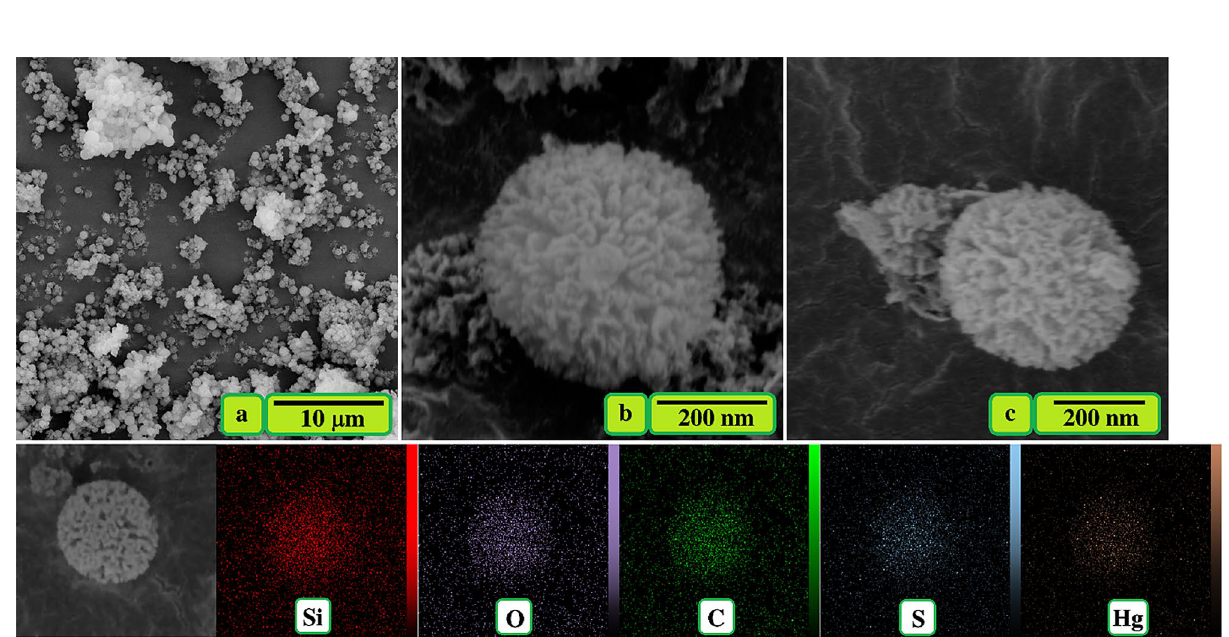
Figure 4. FESEM ( a – c , first row) and EDS elemental mapping (second row) images of TSF-KCC-1 adsorbent after Hg(II)